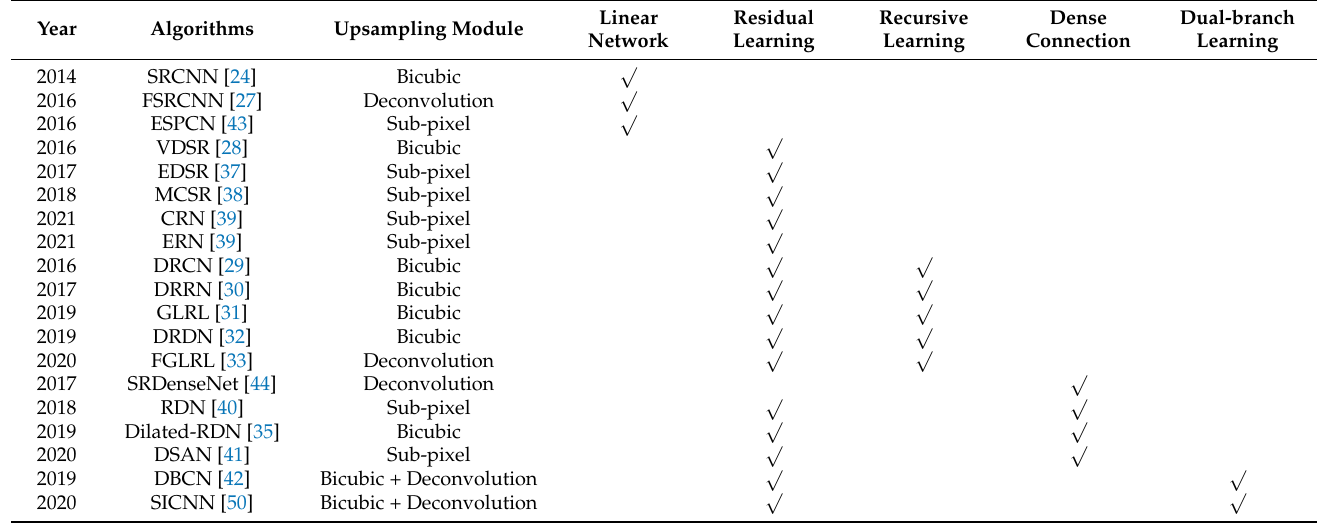
Table 5. Summary table of algorithms corresponding to the upsampling module and network design